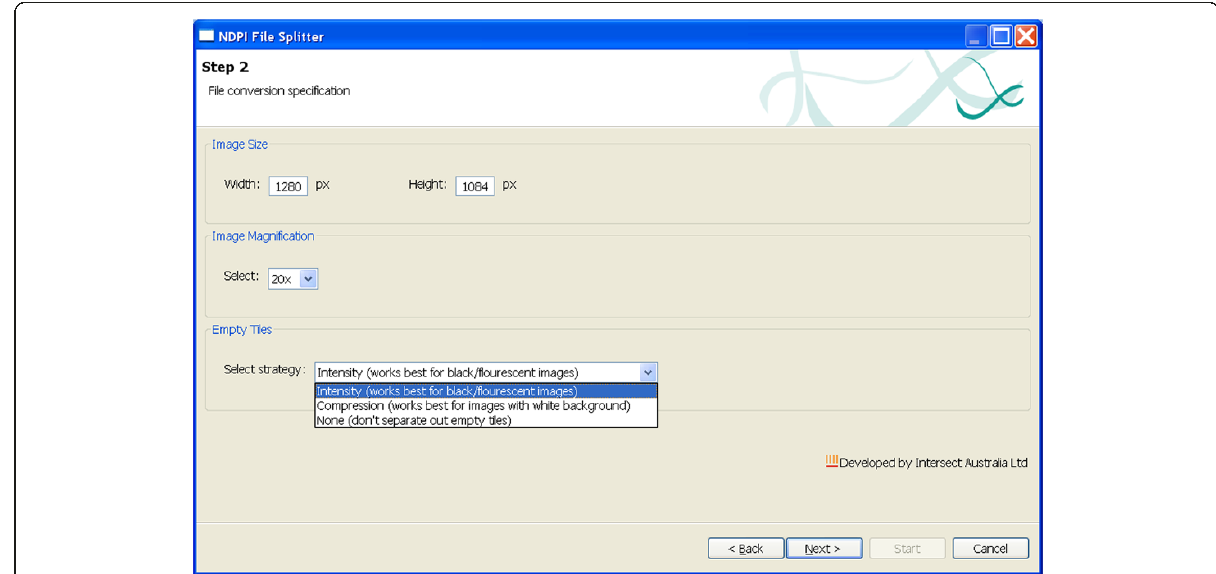
Figure 5 Step-2 of NDPI-Splitter: At step 2 the width and height of each image section, and the magnification level, can be defined, and there is an option to filter out empty